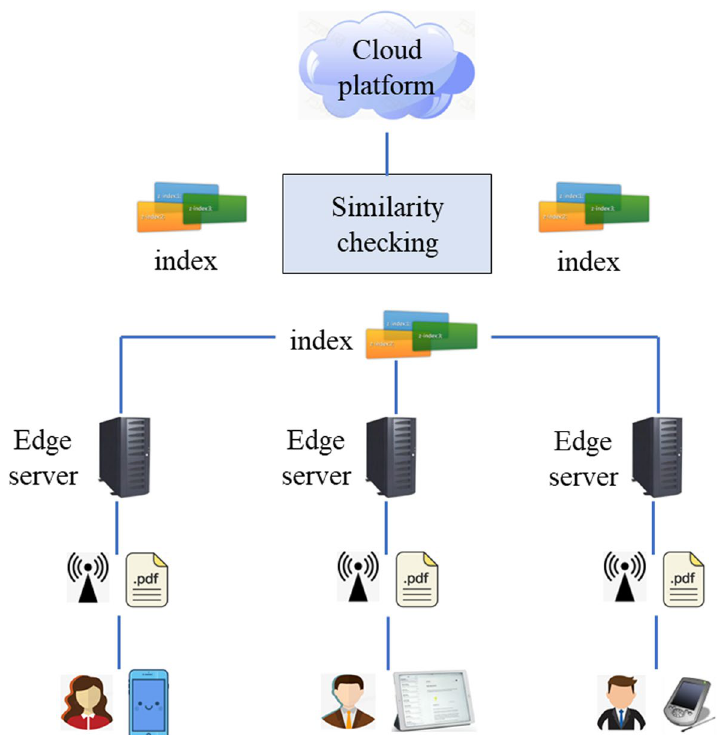
Fig. 1 Three-layer framework of literature similarity checking in mobile edge